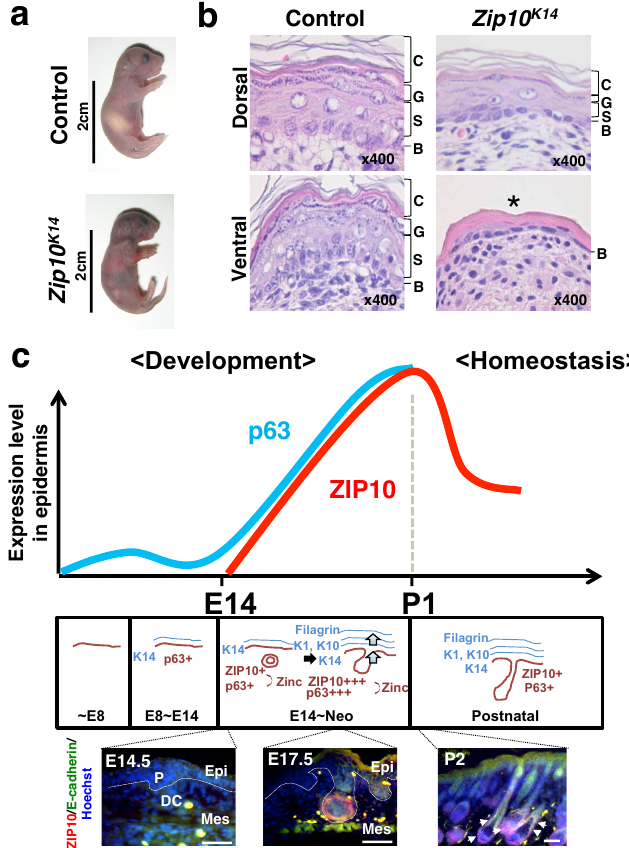
Figure 3. ZIP10 reinforces p63 function for epidermis development. ( a ) ZIP10 deficiency leads to epidermal hypoplasia in mice. ( b ) Hematoxylin and eosin staining revealed dorsal epidermal hypoplasia and ventral embryonic epidermis (asterisk) in P1 Zip10 K14 mice. C, cornified layer; G, granular layer; S, spinous layer; B, basal layer. ( c ) Model for ZIP10’s involvement in p63 function during epidermis development. ZIP10, whose expression is elevated from E14, contributes to the activities of increased p63 by supplying zinc. This allows p63 to properly bind to DNA for initiating gene expression for epidermis development, including cell proliferation and stratification. DC, dermal condensate; Epi, epithelium; Mes, mesenchyme; P, placode (Scale bar, 100 µ m). Red (E17.5) and arrows (P2) indicate the ZIP10 protein expression. Modified from Bin et al.